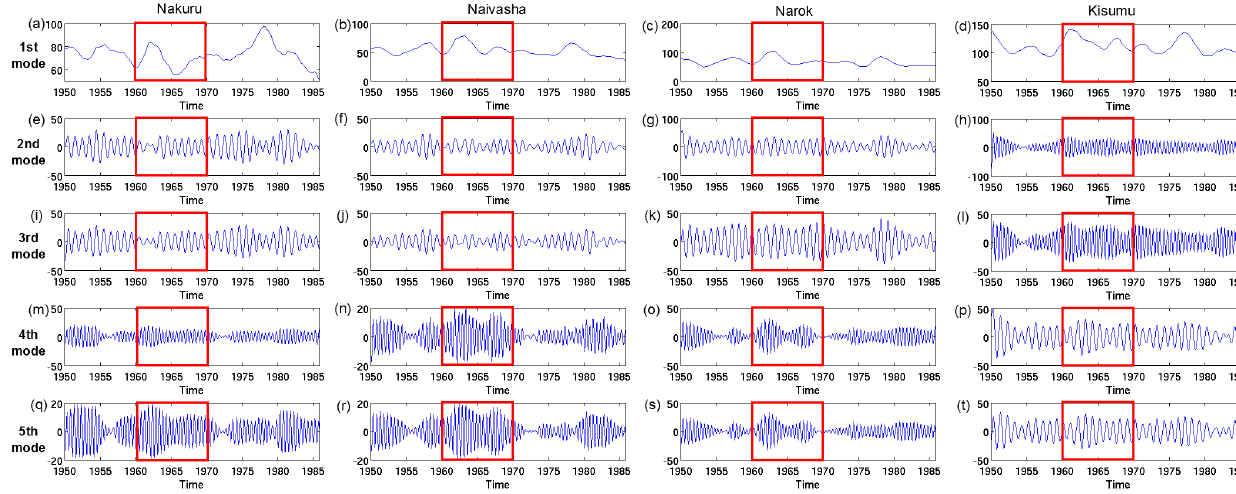
Fig. 17. First 5 reconstructed time series by SSA. (a), (e), (i), (m), and (q) for Nakuru. (b), (f), (j), (n), and (r) for Naivasha. (c), (g), (k), (o), and (s) for Narok. (d), (h), (l), (p), and (t) for Kisumu. (a)–(d) show the slowly varying trend components. (e)–(t) show the frequent components. The red rectangles between 1960–1969 mean the interesting decade in this study.